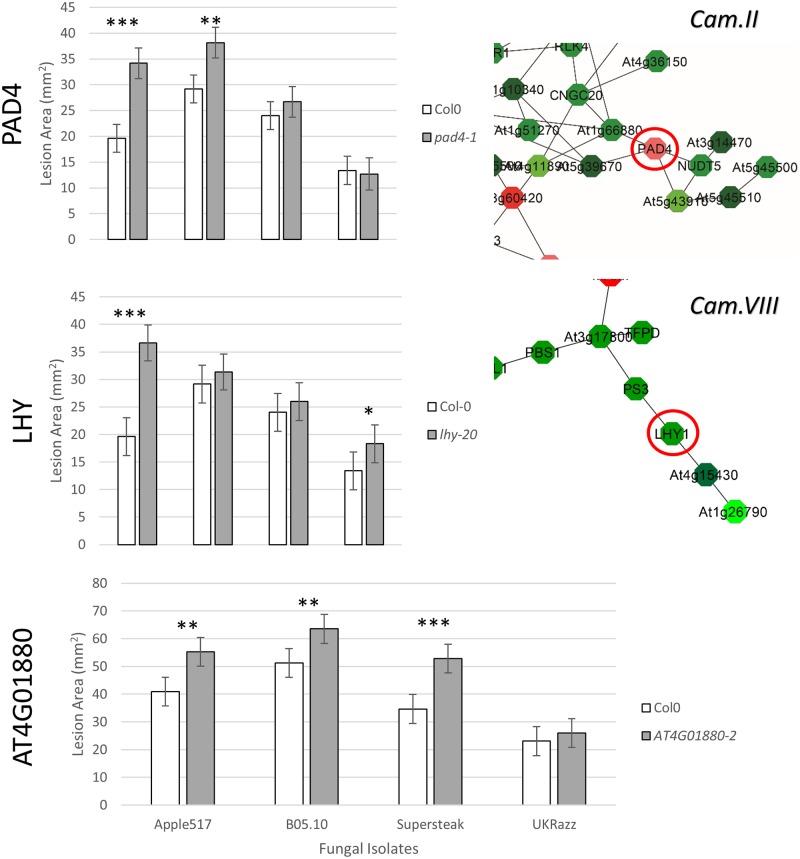
Lesion area validation.Bargraphs showing the model corrected means for the lesion area on wildtype Col-0 versus pad4-1, lhy-20, and at4g01880-2 mutants. Relevant co-expression networks for PAD4 and LHY1 are shown to right of the bargraph. Significance of the difference in camalexin accumulation between Col-0 and the mutant with each isolate are shown as P< 0.001 ‘***’, 0.001 ‘**’ and 0.01 ‘*’.